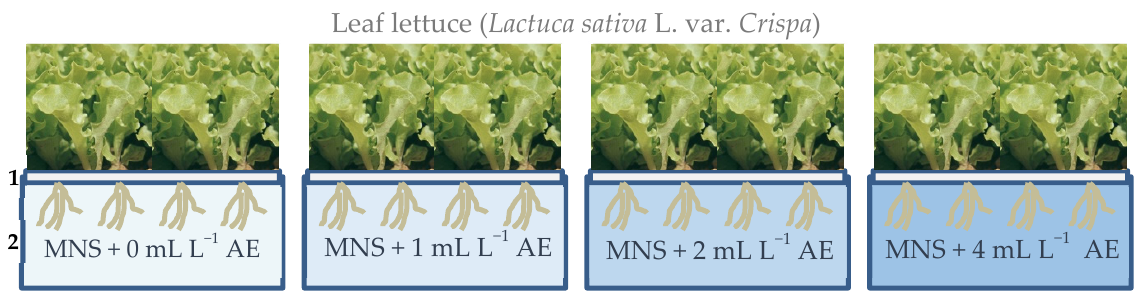
Figure 1. Graphical representation of the hydroponic floating system made of drilled polystyrene panels floating on mineral nutrient solutions (MNS) with four levels of Ecklonia maxima extract (AE) ( 1 Drilled polystyrene panels (300 plants m − 2 ) floating on MNS; 2 Tanks filled with 75 L of MNS containing increasing concentrations of Ecklonia maxima extract).